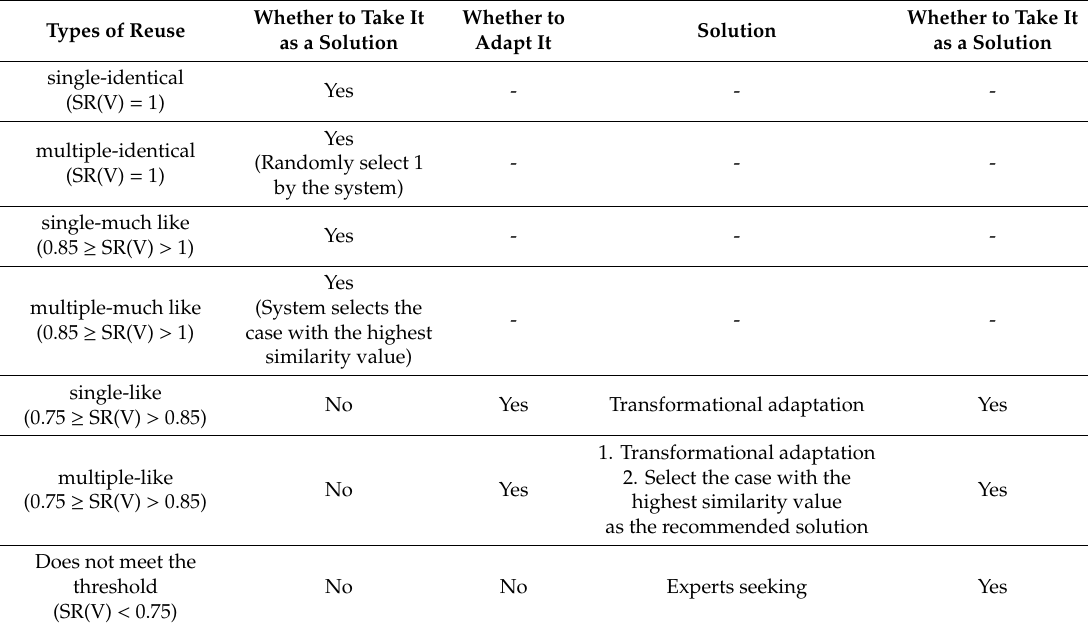
Table 4. Reuse application-types of